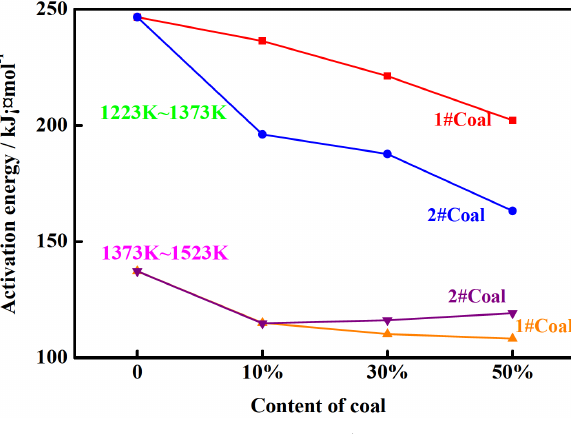
Figure 3: Relationship between reaction activation energy and the additive amount of coal